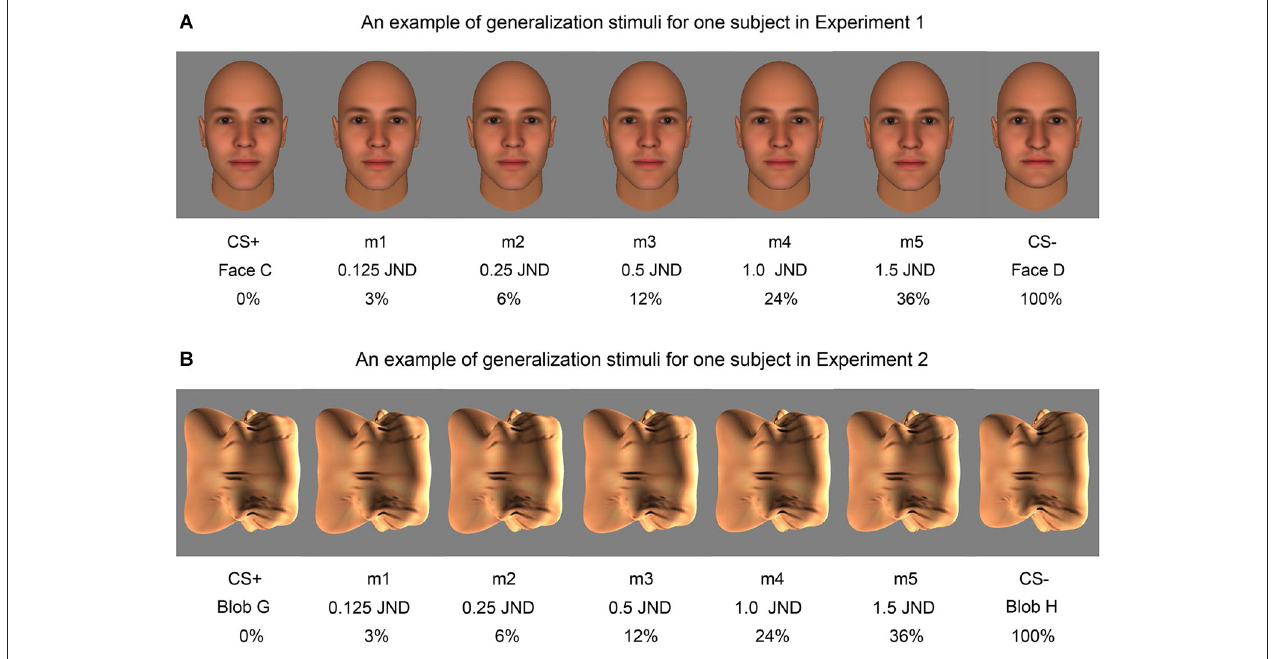
Experiment 2 (B) are displayed. The percentage difference from the CS+ stimulus (Face C and Blob G in these examples) and the fraction of the JND are both included below the corresponding morph (m1, m2, m3, m4,